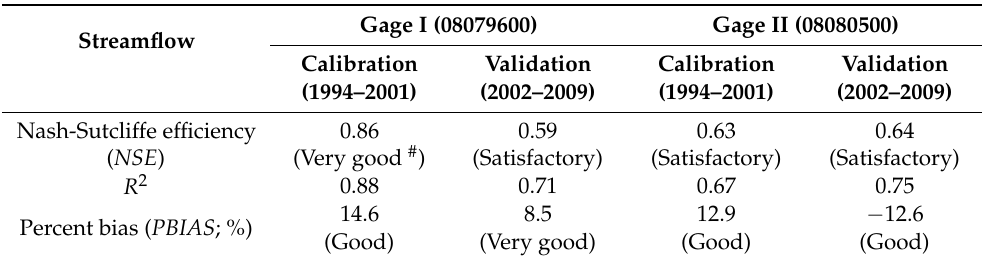
Table 1. Performance statistics for monthly streamflow prediction on two USGS gages in the Double Mountain Fork Brazos basin using the SWAT-MAD